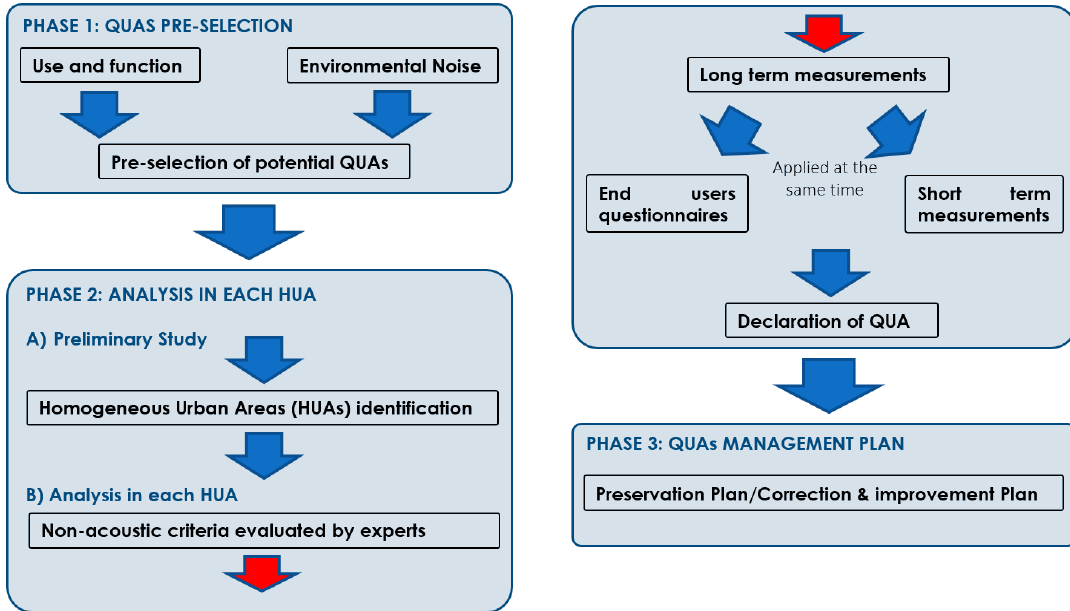
Figure 1: QUADMAP methodology for QUAS selection, analysis and